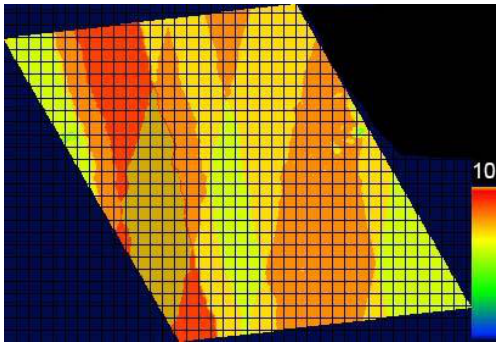
Fig. 5: Color coded multiple coverage of WorldDEM core DSM